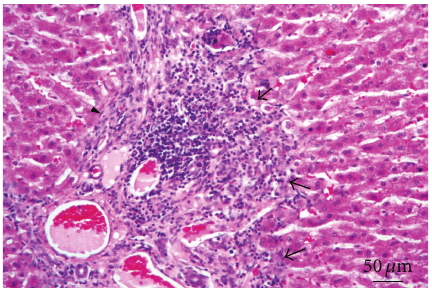
Figure10:Liver.LesionGradeIII.Severeperiportalnonsuppurative interstitial infiltration (arrows), accompanied by fibrosis and necro- sis of periportal area (arrowhead). Hematoxylin and